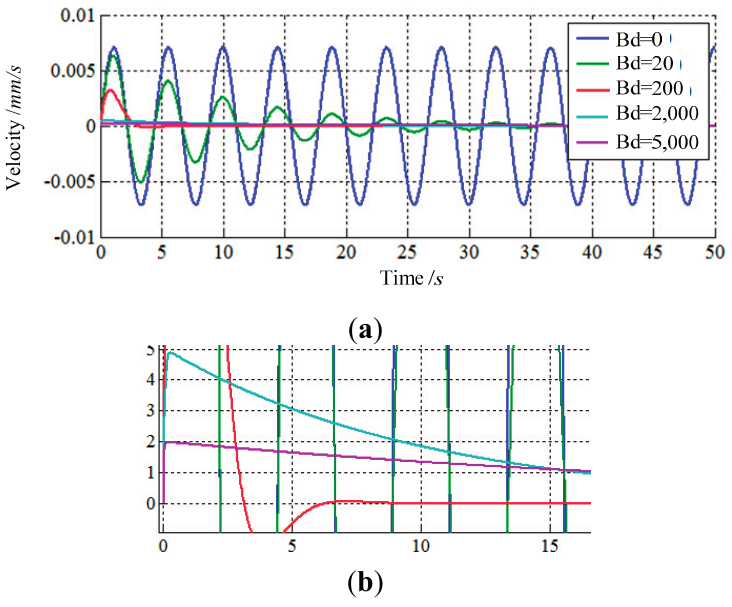
Figure 5. ( a ) The responses of impedance control compensator with changing B d ; ( b ) The partial enlarged detail of Figure 5a.